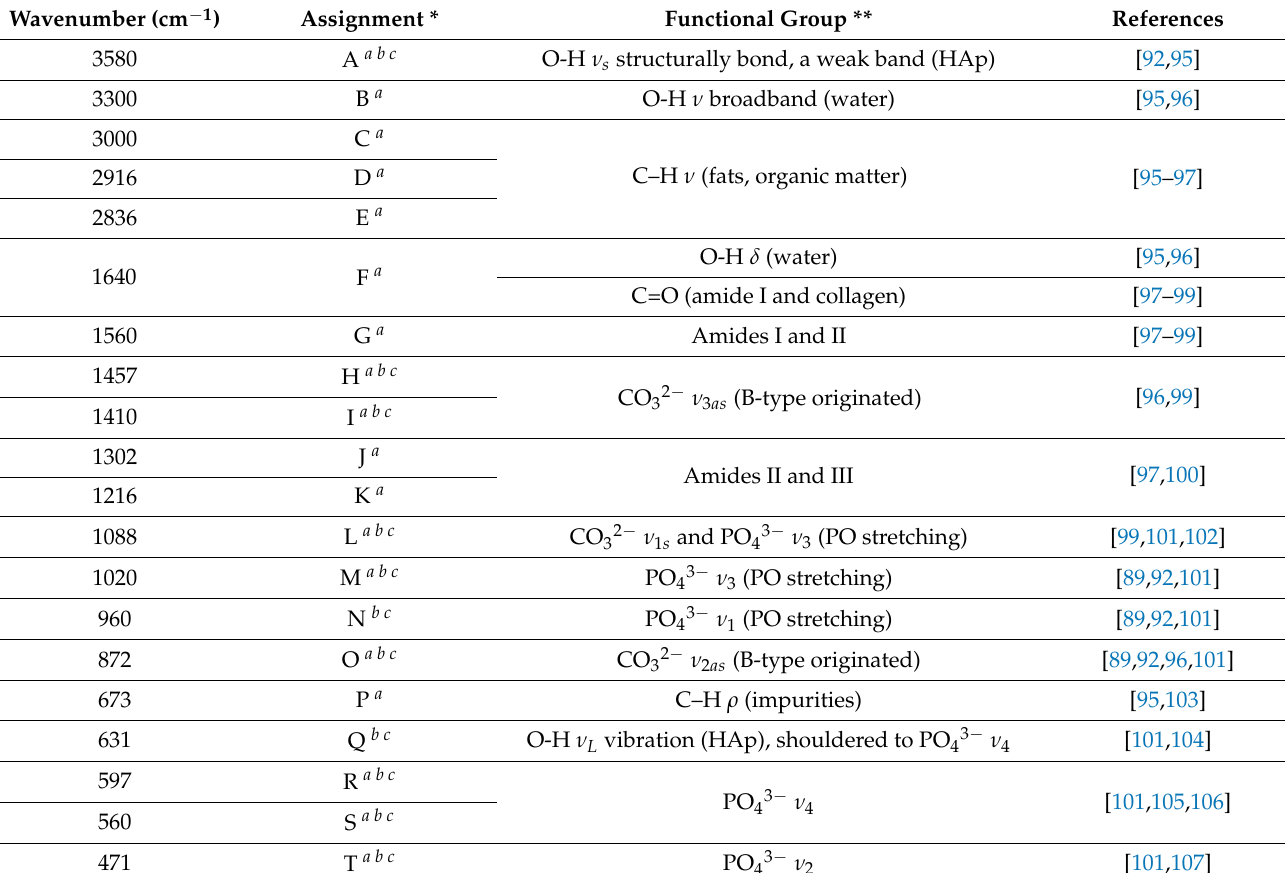
Table 3. FT − IR Spectroscopy for HAp-based materials.